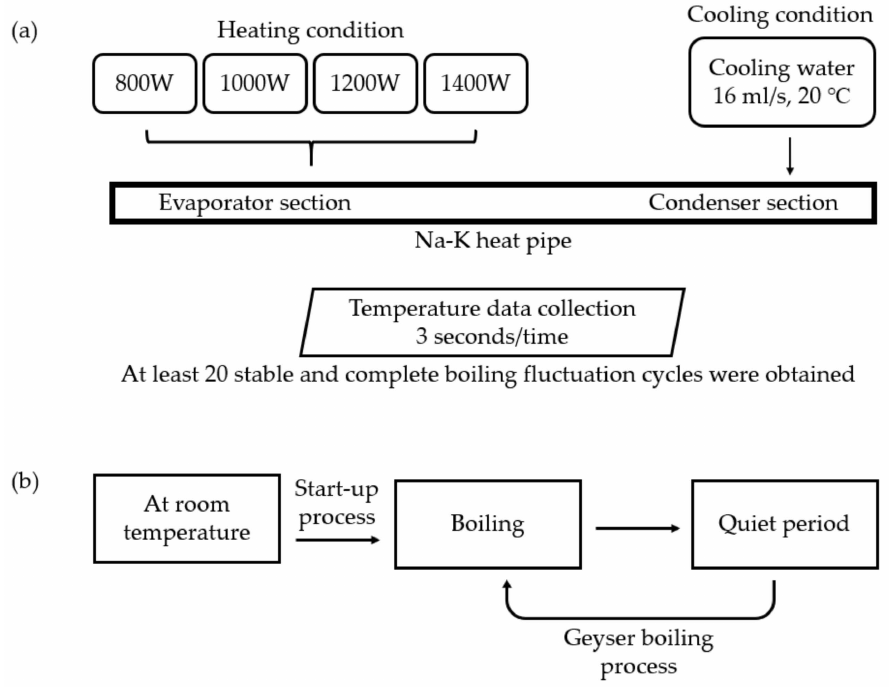
Figure 2. Experimental procedures of Na-K heat pipe of ( a ) Experimental conditions; ( b ) Operation status of Na-K heat